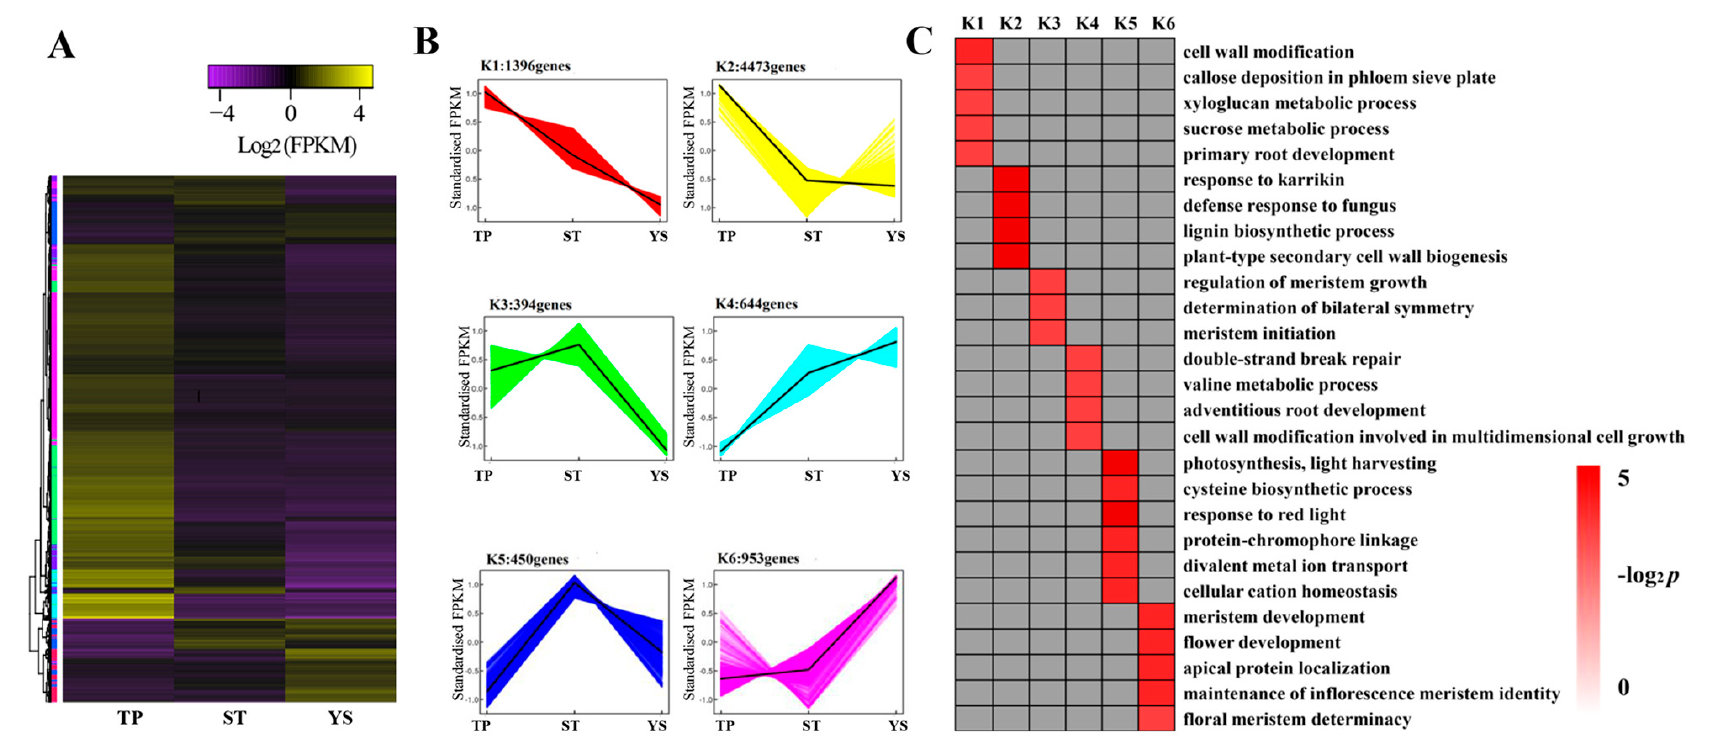
Figure 5. Overview of serial analysis of DEGs identified by pairwise comparisons of TPs (tiller primordia), STs (stem tips), and YSs (young spikes). ( A ) a heatmap of